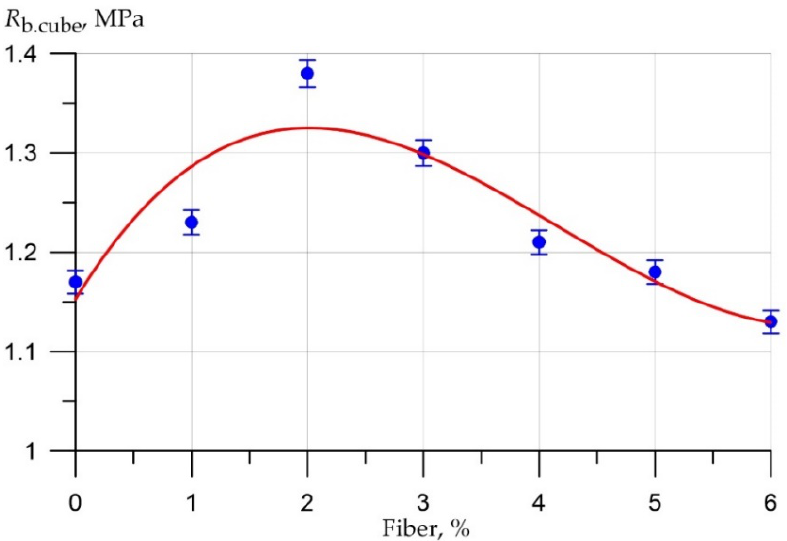
Figure 3. The results of experimental studies of the compressive strength (R b.cube ) of prototypes of fiber foam concrete at various dosages of polypropylene fiber.